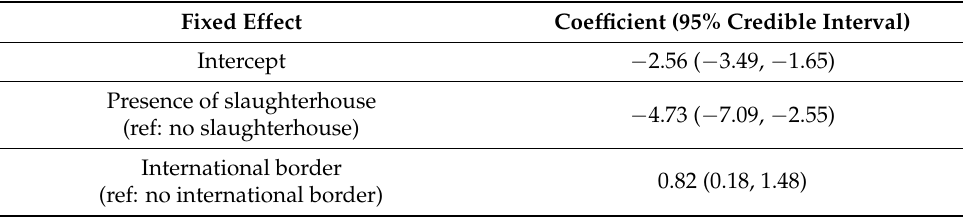
Table 2. Results from the final Bayesian space–time regression model based on the spatial adjacency matrix (DIC 112300).